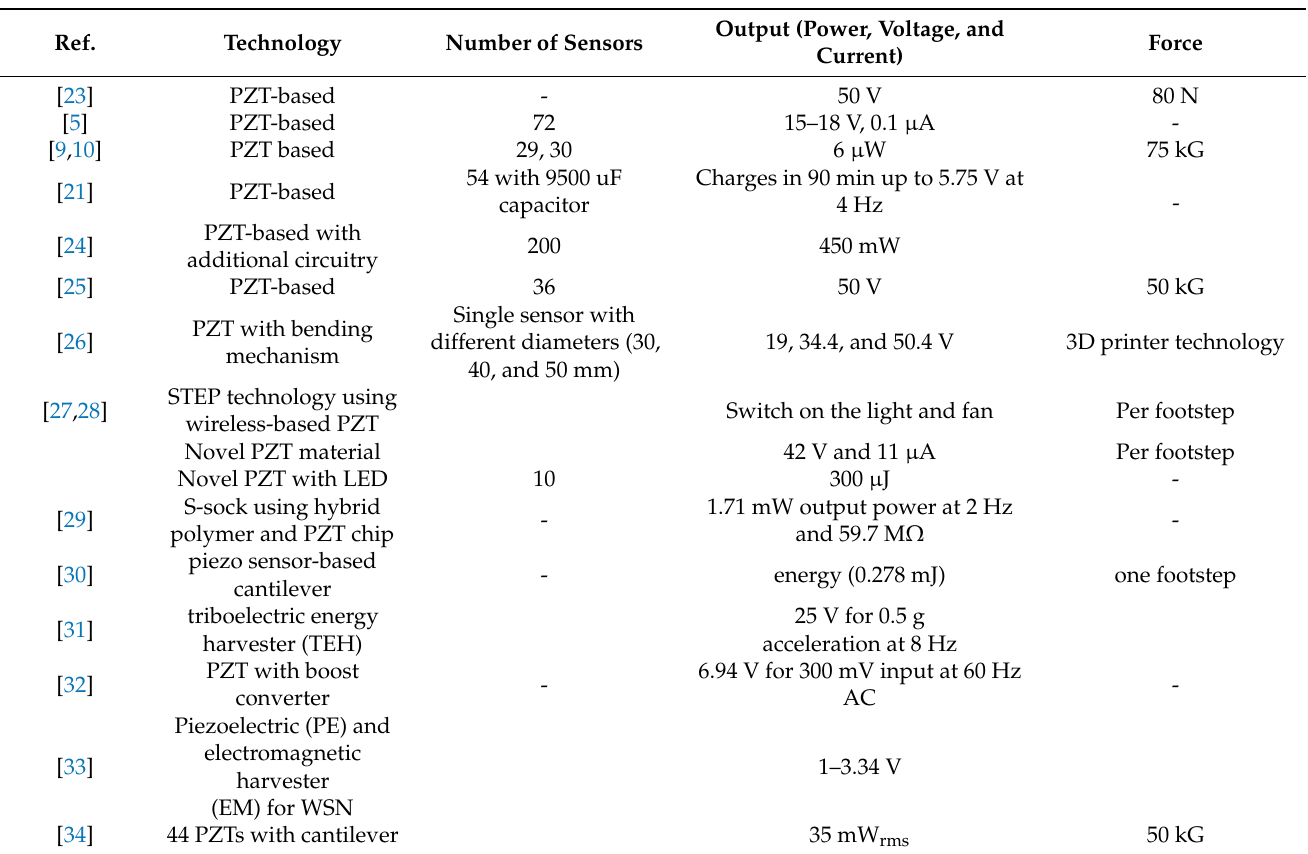
Table 1. Comparative analysis of various available techniques for energy generation using PZT